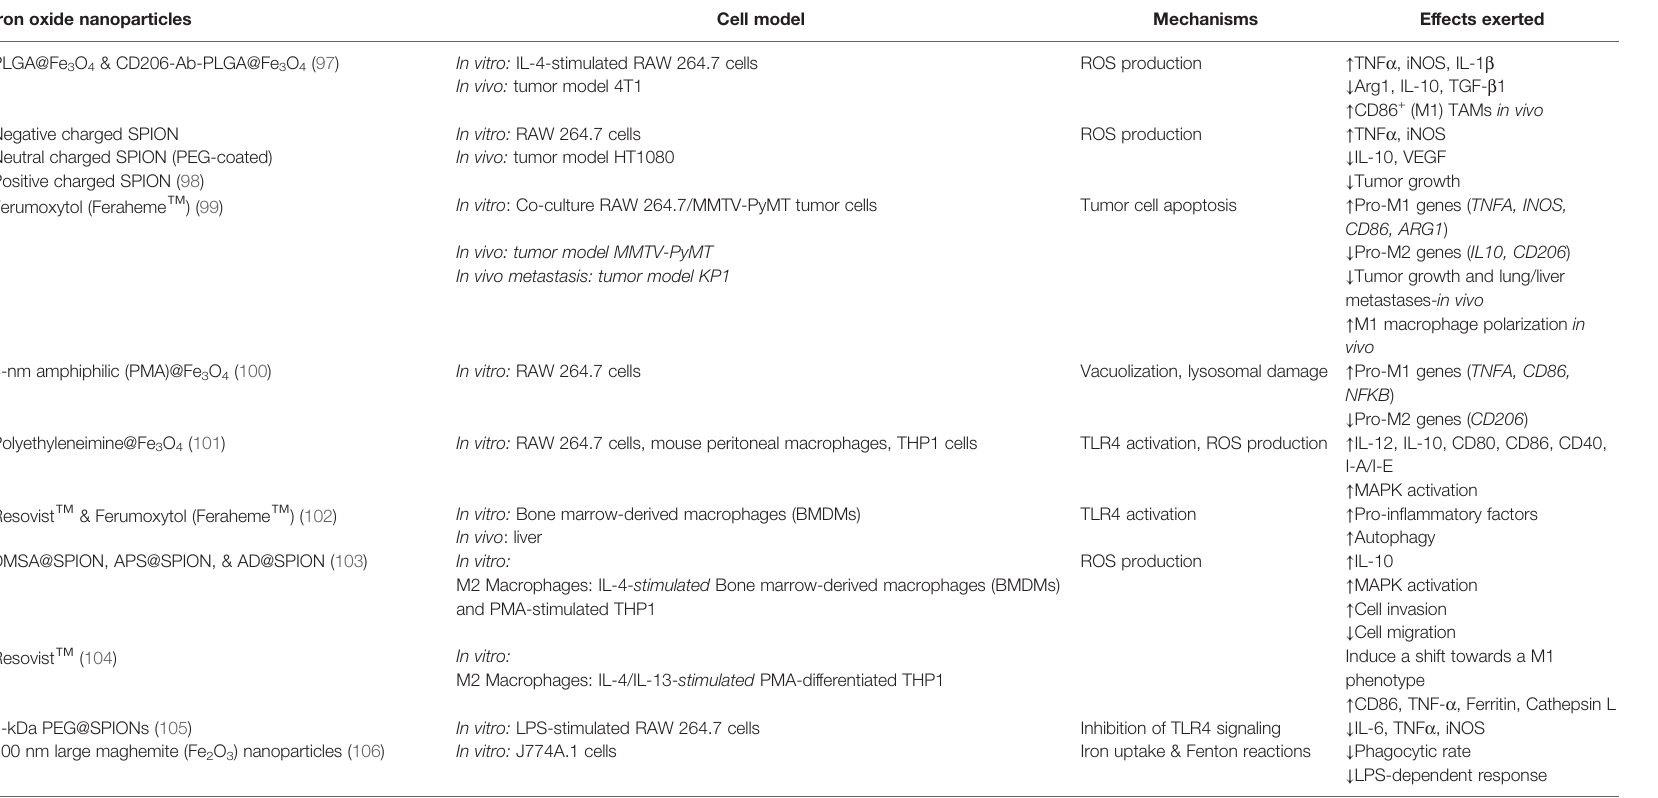
TABLE 3 | | Example of the effects of iron oxide nanoparticles on macrophage polarization. Iron oxide